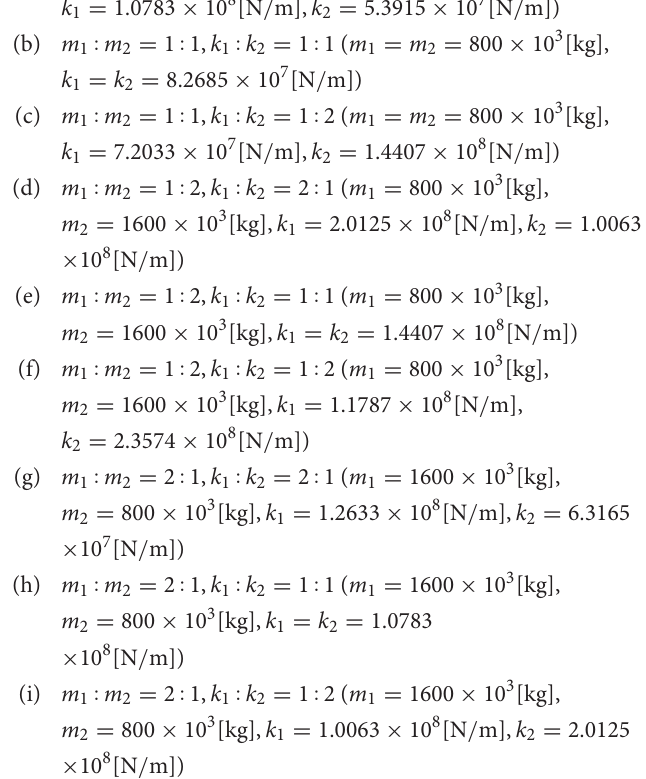
k 1 = 1.0783 × 10 8 [N / m], k 2 = 5.3915 × 10 7 [N /